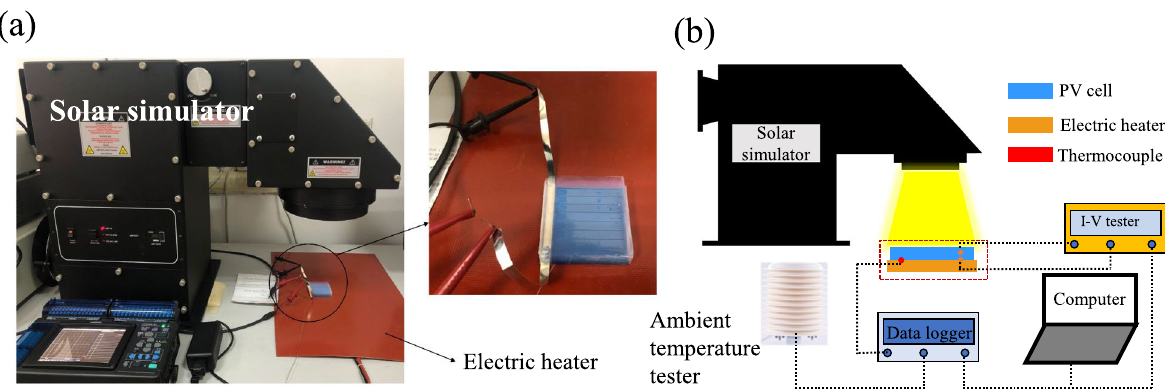
Fig. 5 Photo and schematic for measuring electrical